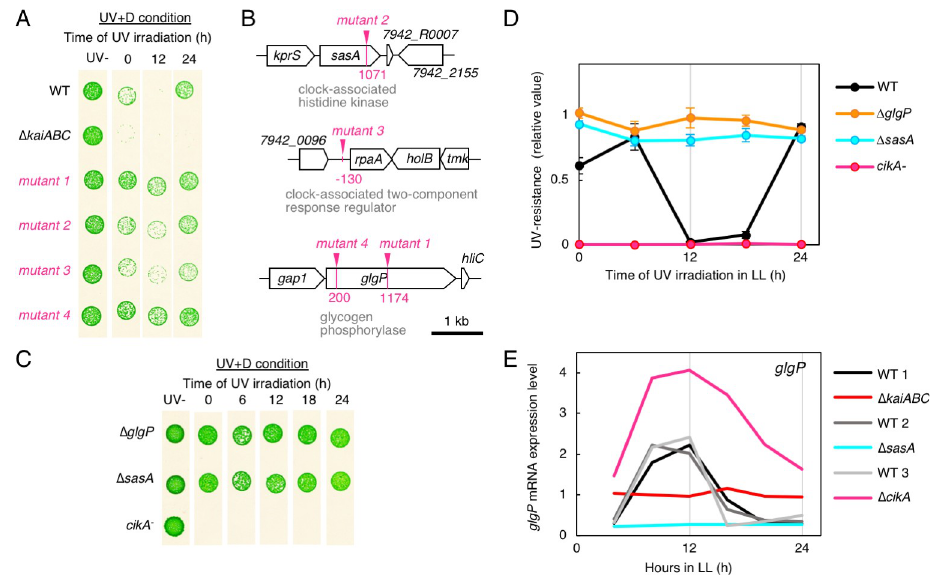
Fig 4. Isolated mutants showed loss of circadian UV-C resistance. (A) Effects of UV-C irradiation on isolated mutants under the UV+D condition. Each image represents a spot assay to assess growth as shown in Fig 2B. (B) Mapping of Tn-5 insertions. The Tn-5-insertion sites of each UV resistance mutant are indicated by arrowheads. The mutations were mapped onto the open reading frames (ORFs) of the glgP and sasA genes, and the upstream region of rpaA . The function of each gene is indicated under each gene symbol. The numbers under the arrowheads indicate the positions of insertion sites when the start of the ORF of each mutated gene is assigned a positional value of 1. (C) Growth of the UV-C-irradiated cells of each re-constructed mutant strain ( Δ glgP , glgP -null strain; Δ sasA , sasA -null strain; cikA - , circadian input kinase cikA -deficient strain) under the UV+D condition. Each image represents the result of a spot assay to assess the growth of each mutant following UV irradiation at each time point. Representative data of three independent experiments are shown. (D) Densitometric analysis of the growth test in Fig 4C. The timing of UV irradiation is shown on the horizontal axis, and relative UV resistance is shown on the vertical axis, as in Fig 1C ( n = 3). Error bars represent standard deviation. (E) glgP mRNA accumulation profile in each mutant strain. The glgP expression level from microarray data reported in the previous studies is shown. The microarray data were extracted for Δ kaiABC and the corresponding control wild type (shown here as WT1) strains from Ito et al . [14], for Δ sasA and its control (WT2) strains from data available at (NCBI, Gene Expression Omnibus databank, #GSE28430), and Δ cikA and its control (WT3) strains from Pattanayak et al . [33]. The expression data of glgP in each WT strain were normalized to the average of